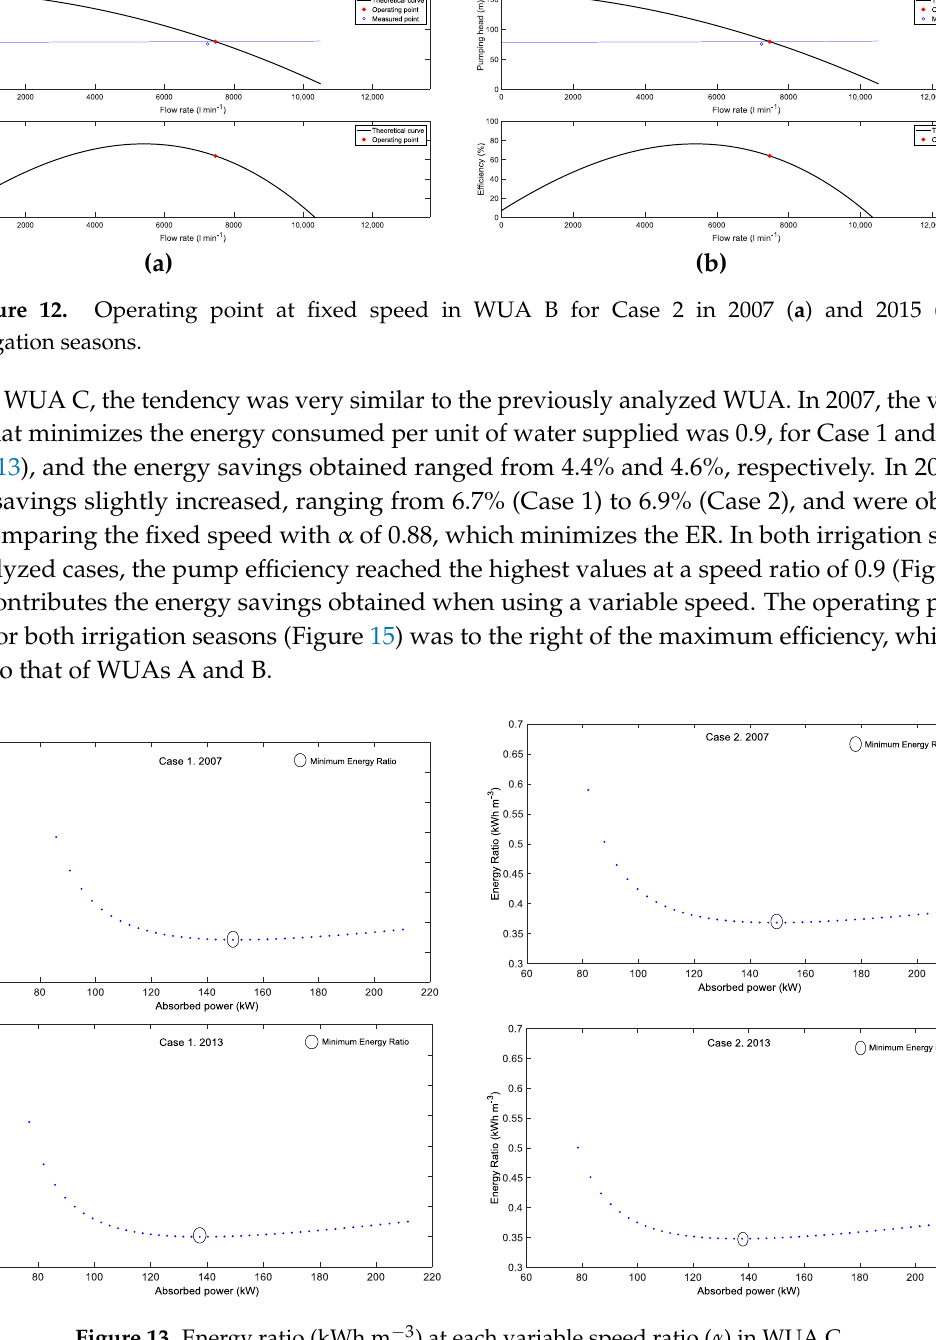
Figure 11. Pump efficiency (%) depending on the variable speed ratio in WUA B.